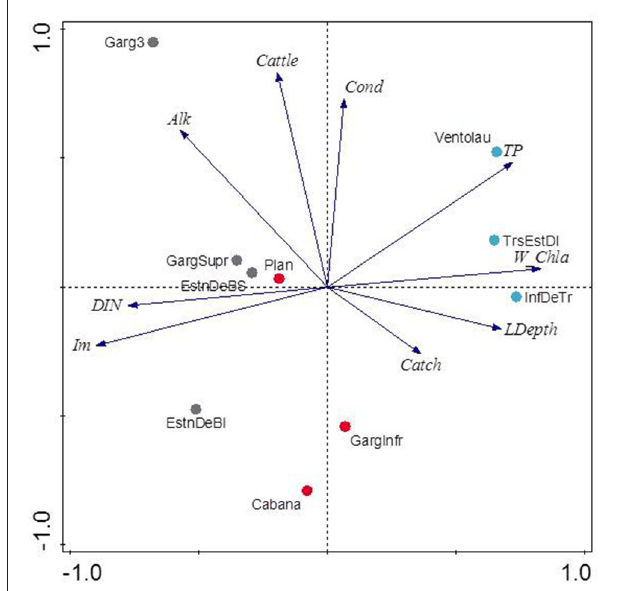
FIGURE 3 | Principal Component Analysis (PCA) of the water column physico-chemistry and morphological parameters from ten lakes. Gray symbols are fishless lakes, red as for lakes invaded with trout and blue as for lakes invaded with dense minnow populations. Percentage of the variance explained by the first two axes is 39.9% and 22.2%, respectively. See Table 1 for variables abbreviation and Annex 1 Supplementary Materials for the